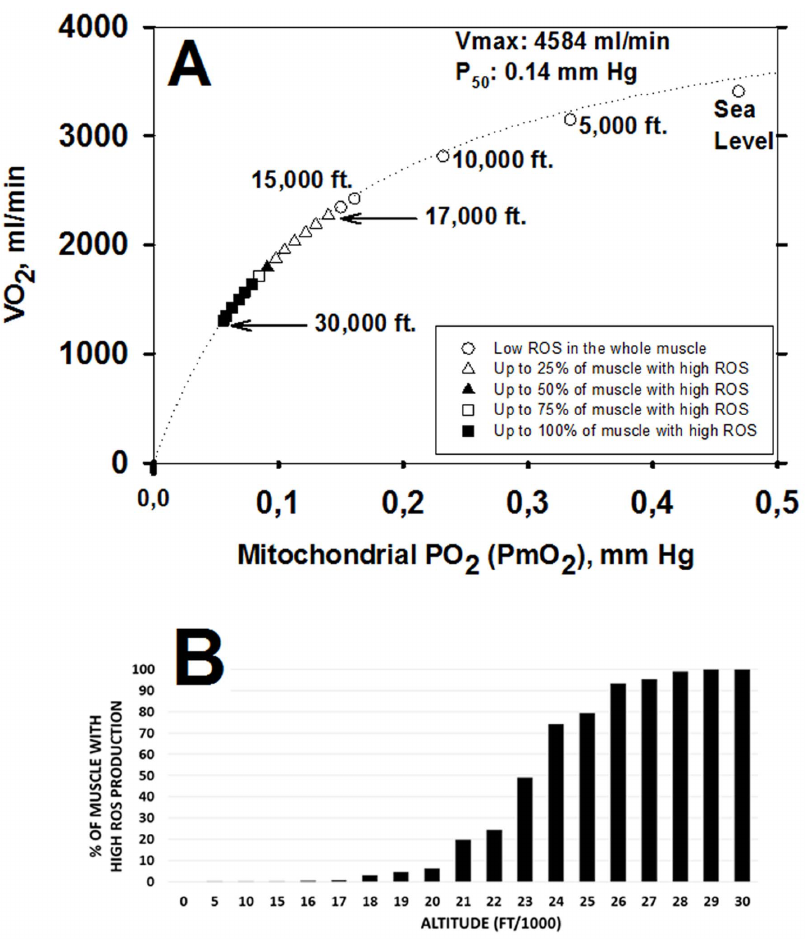
Figure 5. Effect of altitude on ROS generation when considering typical values for lung and muscle heterogeneities. A: Between 0 and 17,000 ft., ROS generation is within the normal range throughout the exercising muscle (open circles). Open triangles indicate that between 17,000 and 22,000 ft., abnormally high levels of ROS are predicted in up to 25% of exercising muscle (in regions with highest metabolic capacity in relation to O 2 transport). The closed triangle (23,000 ft.) indicates high ROS in 25 to 50% of muscle. The open square (24,000 ft.) indicates 50–75% of muscle has high levels of ROS and filled squares (25,000–30,000 ft.) show that 75–100% of muscle regions express high levels of ROS (see text for more details). B: shows in more detail the percentage of exercising muscle that generates abnormally high levels of ROS at each altitude.